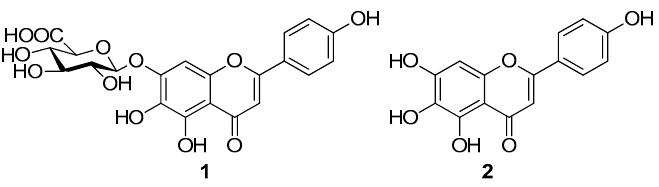
Figure 1. Structures of scutellarin ( 1 ) and scutellarein ( 2 ).